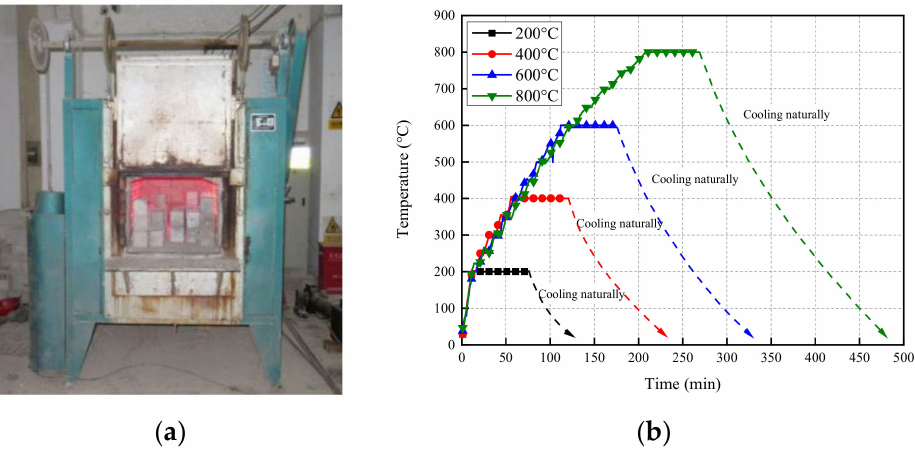
Figure 2. Heat treatment: ( a ) samples in the furnace; ( b ) heating curves of the